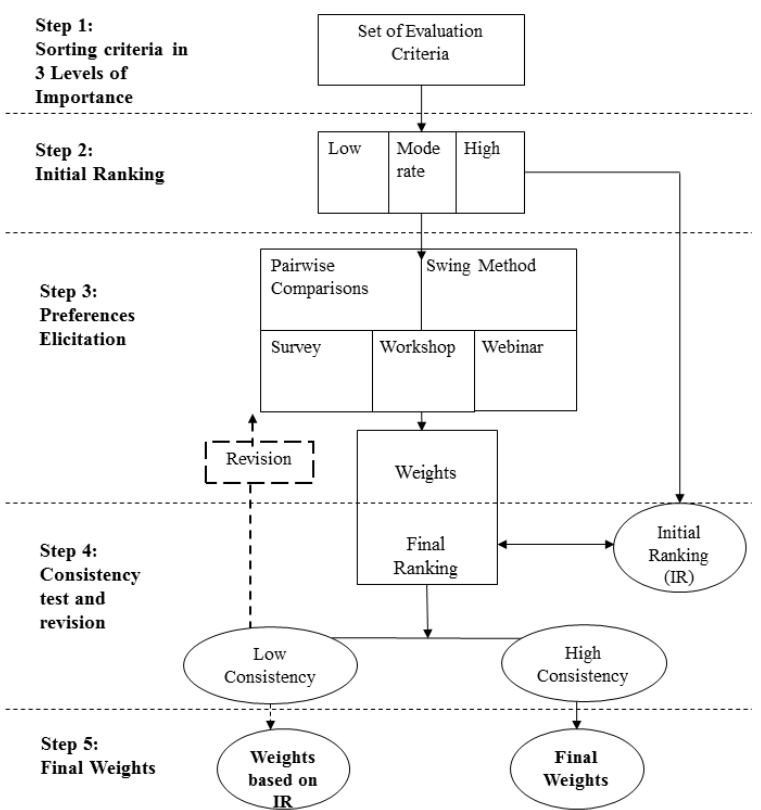
Figure 1. Schematic representation of the hybrid weighting preferences’ elicitation